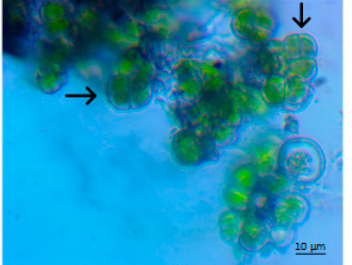
Figure 5. A microscope image of Apatococcus lobatus .